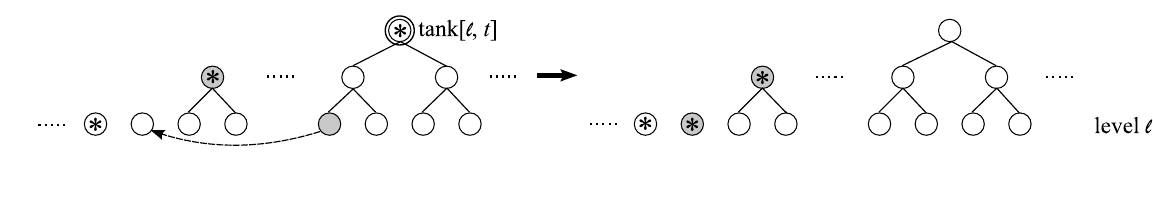
Figure 10. R EPAIR for a rich-bottom-level (cid:96)